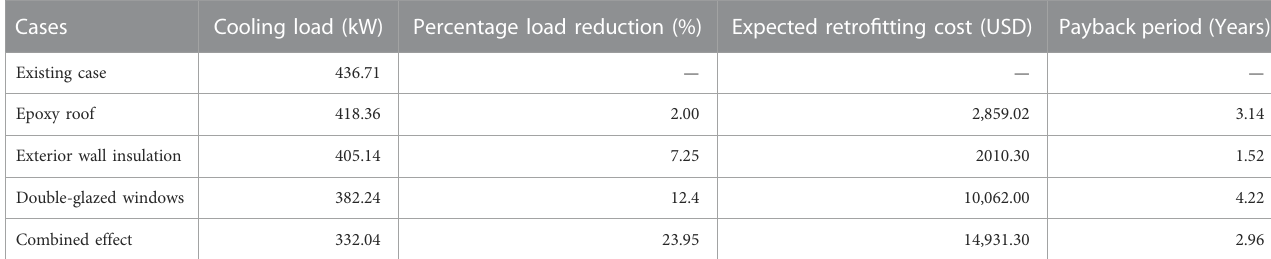
TABLE 6 Payback period for building envelope.